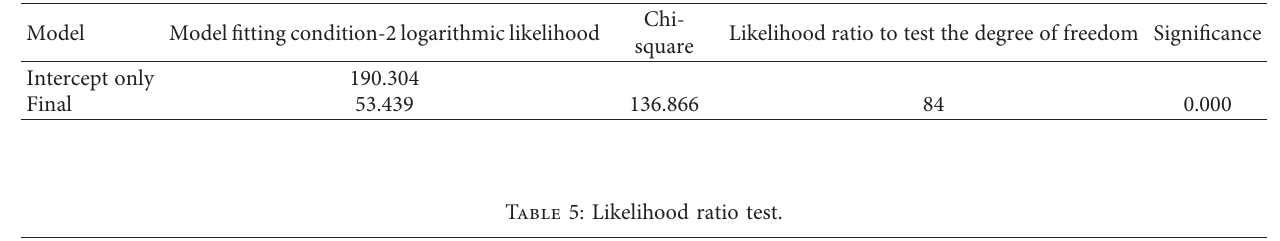
Table 4: Model fitting information.